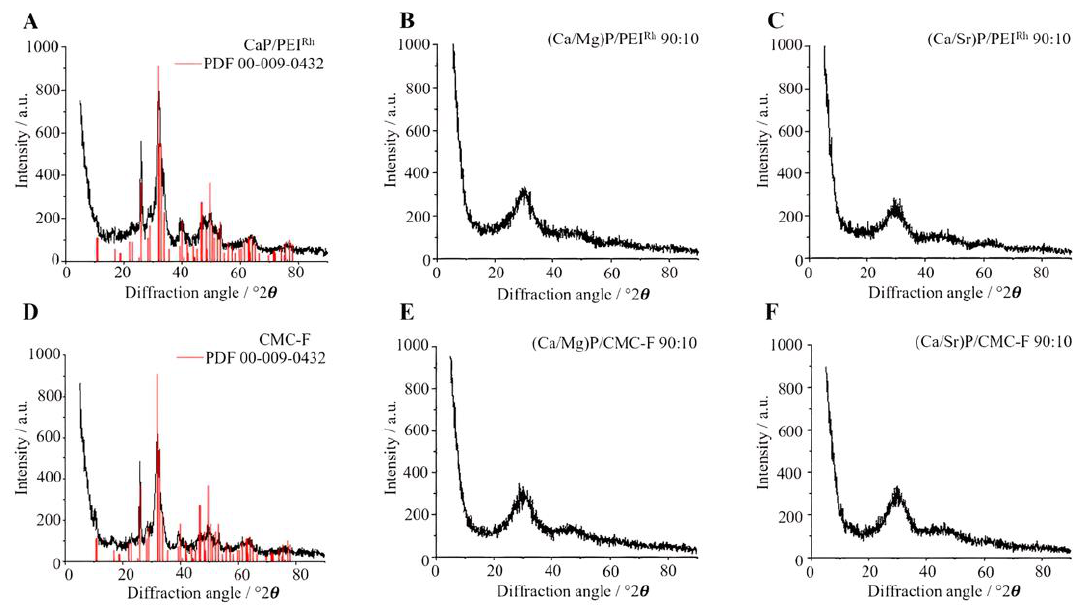
Figure 5. Representative X-ray powder diffractograms of calcium phosphate nanoparticles ( A , D ), magnesium-doped calcium phosphate nanoparticles ( B , E ); and strontium-doped calcium phosphate nanoparticles ( C , F ). The doping with magnesium or strontium considerably decreased the particle crystallinity. The diffraction peaks of the reference for hydroxyapatite (JCPDS No. 00-009-0432) are inserted as red bars. The increase in the diffraction intensity towards low angles is due to the primary (incoming) X-ray